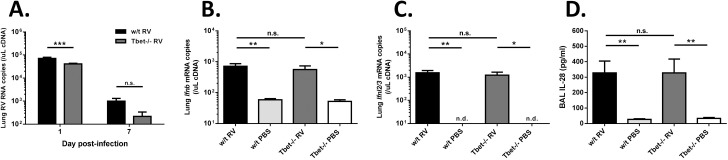
Lung virus loads and interferon responses in Tbet deficient and wild type mice.Wild type and Tbet-/- mice were infected intranasally with RV1B or sham infected with PBS. Lung tissue was harvested on days 1, and 7 post-challenge, RNA extracted and RNA levels were quantified by Taqman qPCR. (A) Lung viral RNA on days 1 and 7 post-infection. (B) Ifnb and (C) ifnl2/3 mRNA levels on day 1 post-infection. (D) Lungs were lavaged on day 1 post-infection and IL-28 levels measured by ELISA. n = 8 mice/group. ***p<0.001, **p<0.01, *p<0.05, n.s. not significant.